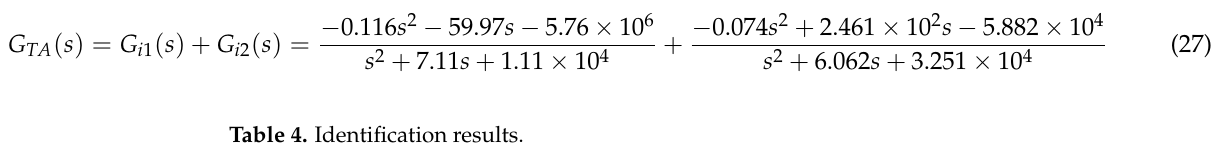
Figure 19. The result of adding two single-degree-of-freedom systems.